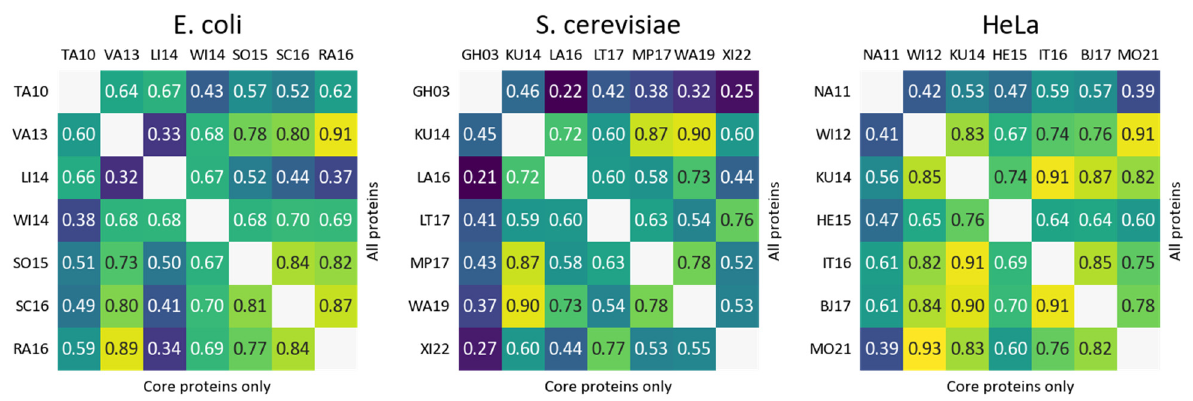
Figure 3. Normalized expression of most and least commonly detected proteins. Proteins per mil- lion denote protein copy number divided by the sum of all protein copies in the dataset and multi- plied by a million.